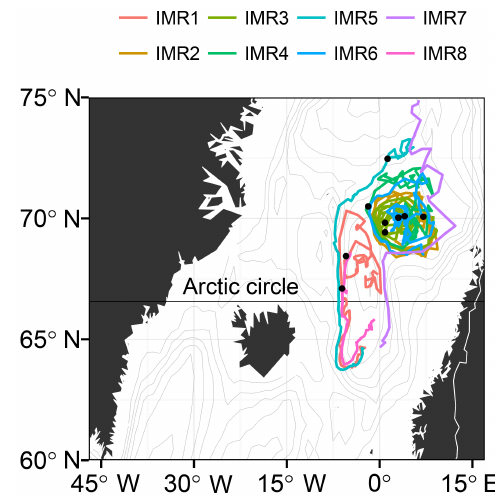
Figure 1. Trajectory of the floats used in the study. The black sym- bols show the location of the floats which profiled North of the Arc- tic Circle (i.e., IMR1, IMR2, IMR3, IMR4, IMR5 and IMR6) at t E